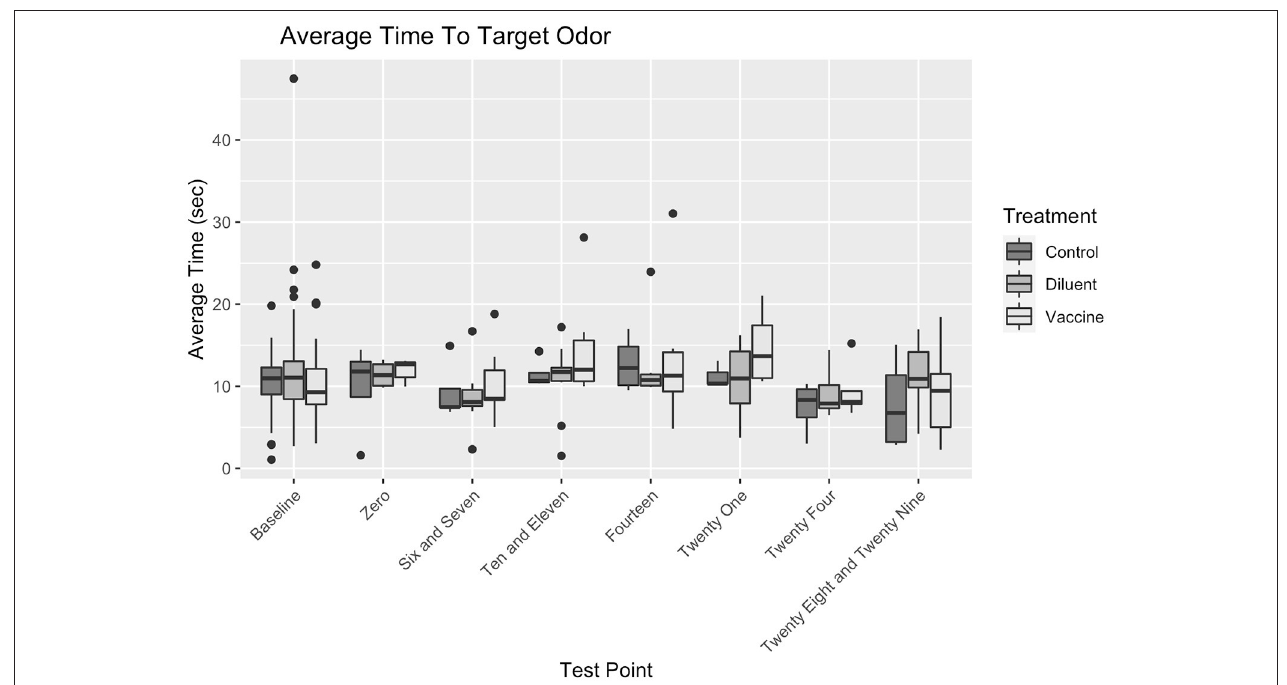
FIGURE 3 | Duration at port by vaccination status and testing day.